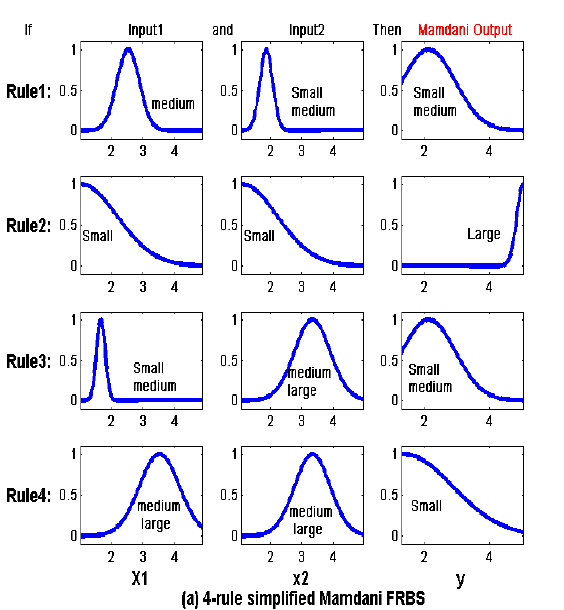
Fig. 9. 4-rule simplified Mamdani FRBS. Fig. 10 show the predictive performances of the simplified Singleton and Mamdani FRBS. For the Singleton FRBS, a 4-rule simplified FRBS with 7 fuzzy sets is chosen for the purpose of illustration.